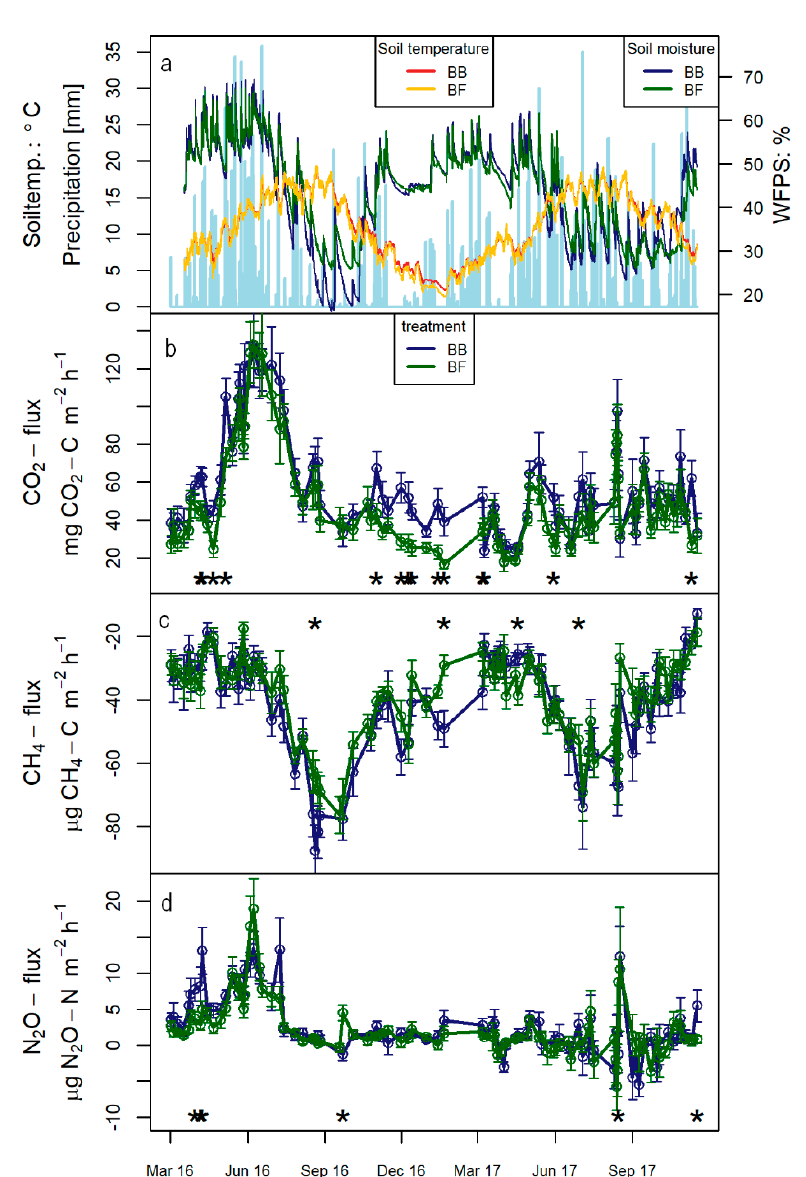
Figure 1. Soil temperature and soil moisture (WFPS: Water filled pore space) ( a ) and the soil-atmosphere exchange of CO 2 ( b ), CH 4 ( c ), and N 2 O ( d ) in the pure beech (BB) and mixed beech fir stands (BF) in the period March 2016 to November 2017: The graph shows the treatment means with standard errors ( n = 5–6). The asterisks indicate significant differences between BB and BF at given sampling dates (Wilcoxon–Mann–Whitney test, p < 0.05).